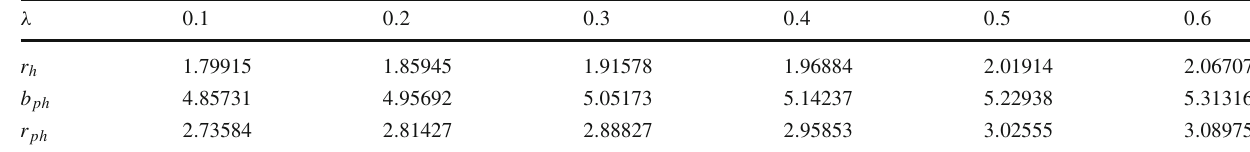
Table 2 The numerical values of r h , b ph , and r ph , for some specific values of λ with φ = 0 . 01, Q = 0 . 1 and M = 1 λ 0 . 1 0 . 2